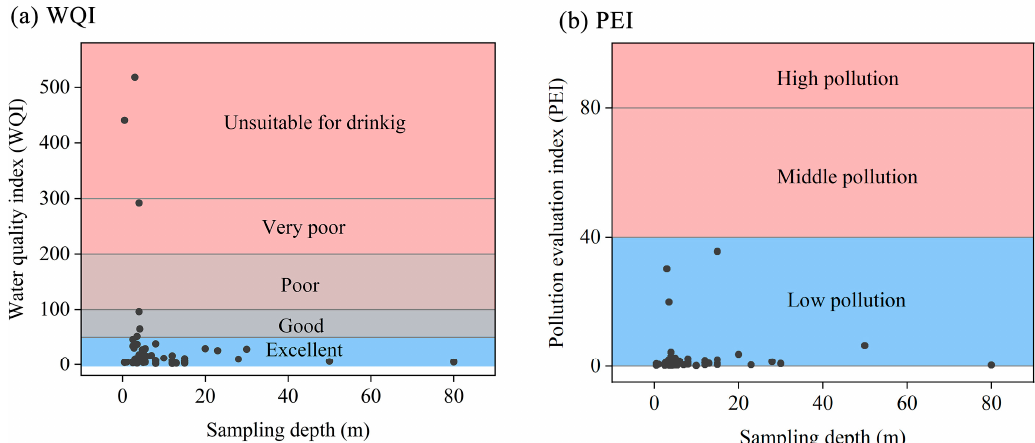
Figure 2. Classification of groundwater in Hainan Island based on ( a ) water quality index (WQI) and ( b ) pollution evaluation index (PEI).